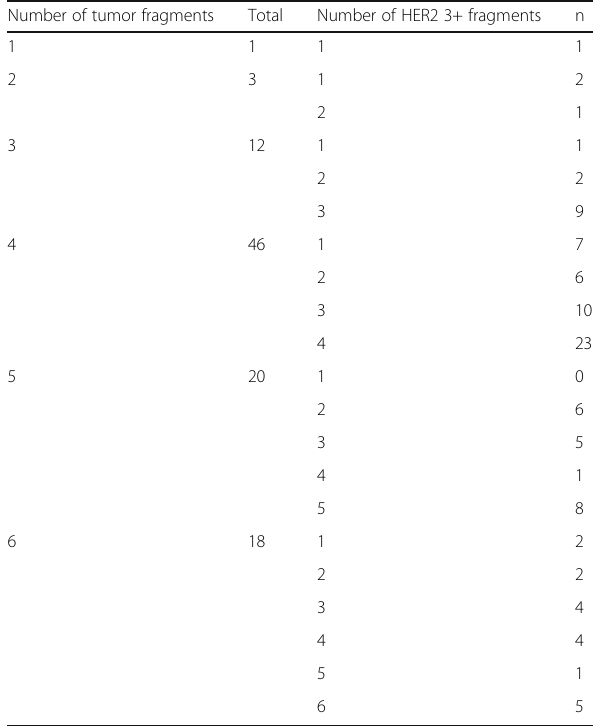
Table 3 Tumor-containing fragment number and HER2-positive fragment number in HER2 IHC positive patients Number of tumor fragments Total Number of HER2 3+